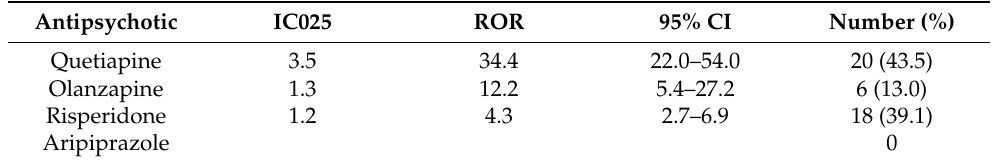
Table 5. Disproportionality analysis for main antipsychotics involved in reports of intentional misuse in patients aged between 2 years and 11 years, ranked by ROR.